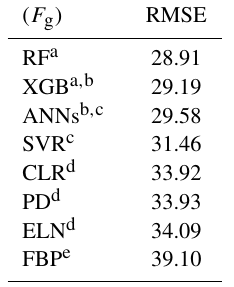
Table 9. The average RMSE for F g gap-filling based on the algo- rithms using the Tukey’s HSD test at the level of 0.05.